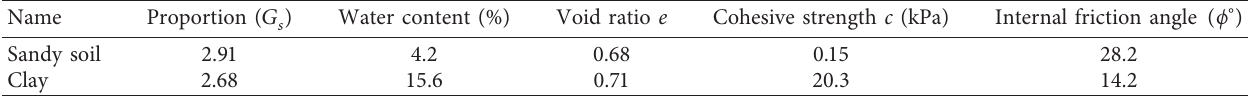
Figure 3: Strain gauge distribution diagram of pile groups with low pile caps. Table 2: Performance parameters of